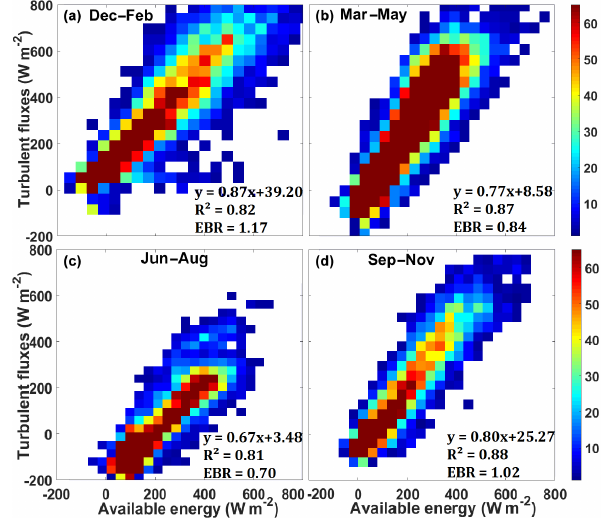
Figure 3. Seasonal turbulent fluxes (H + LE) correlation to available energy (Rn − G) for Skukuza flux tower from sum- mer (December–February), autumn (March–May), winter (June– August), and spring (September–November). The colour bars rep- resent the count of EBR